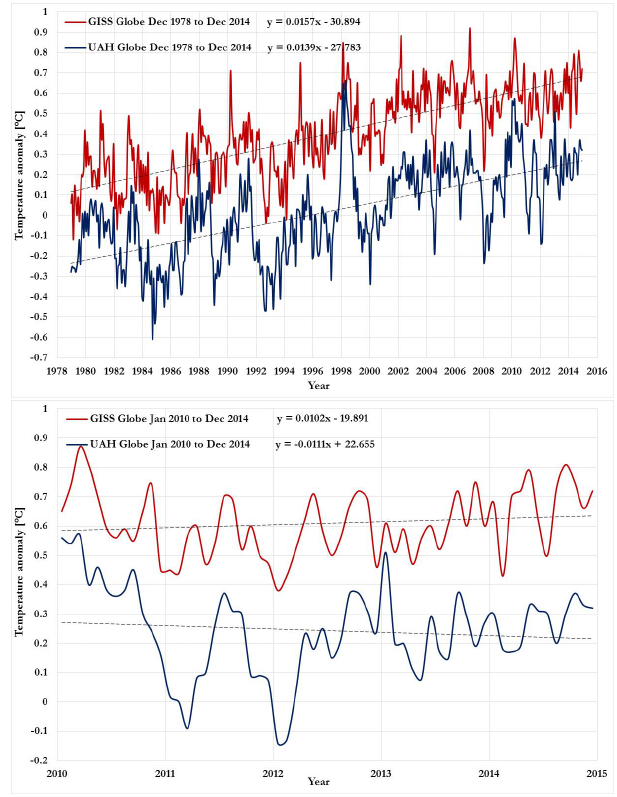
Fig. 1: Comparison of the UAH and GISS global temperatures Decem- ber 1978 to December 2014 and January 2010 to December 2014. Since December 1978, the GISS warming rate is 1.57–1.11 · 10 −2 °C/year, while the UAH result is 1.39–1.11 · 10 −2 °C/year. Over the last 5 years, the difference is increasingly large, with the GISS result returning a + 1.02–1.11 · 10 −2 °C/year and the UAH result showing a cooling of − 1.11 · 10 −2 °C/year. The continuing warming by GISS is the result of a continuing “ adjustment ” of